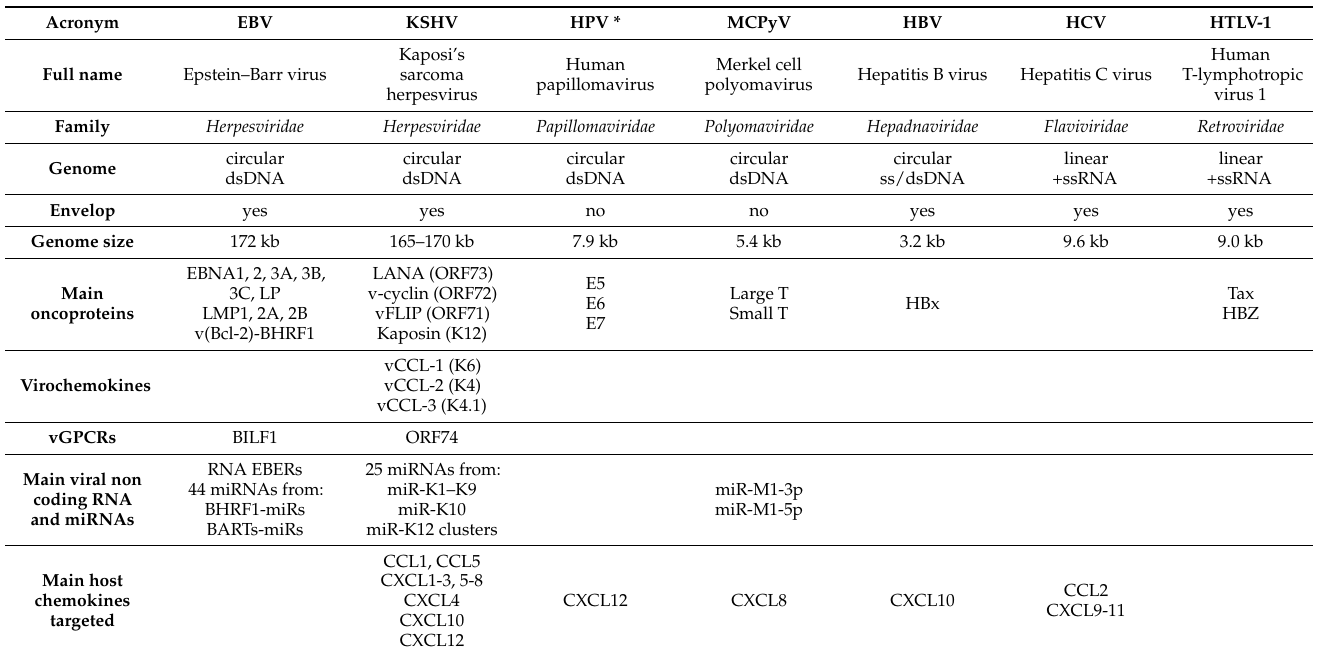
Table 1. Interplay between oncogenic viruses and the chemokine